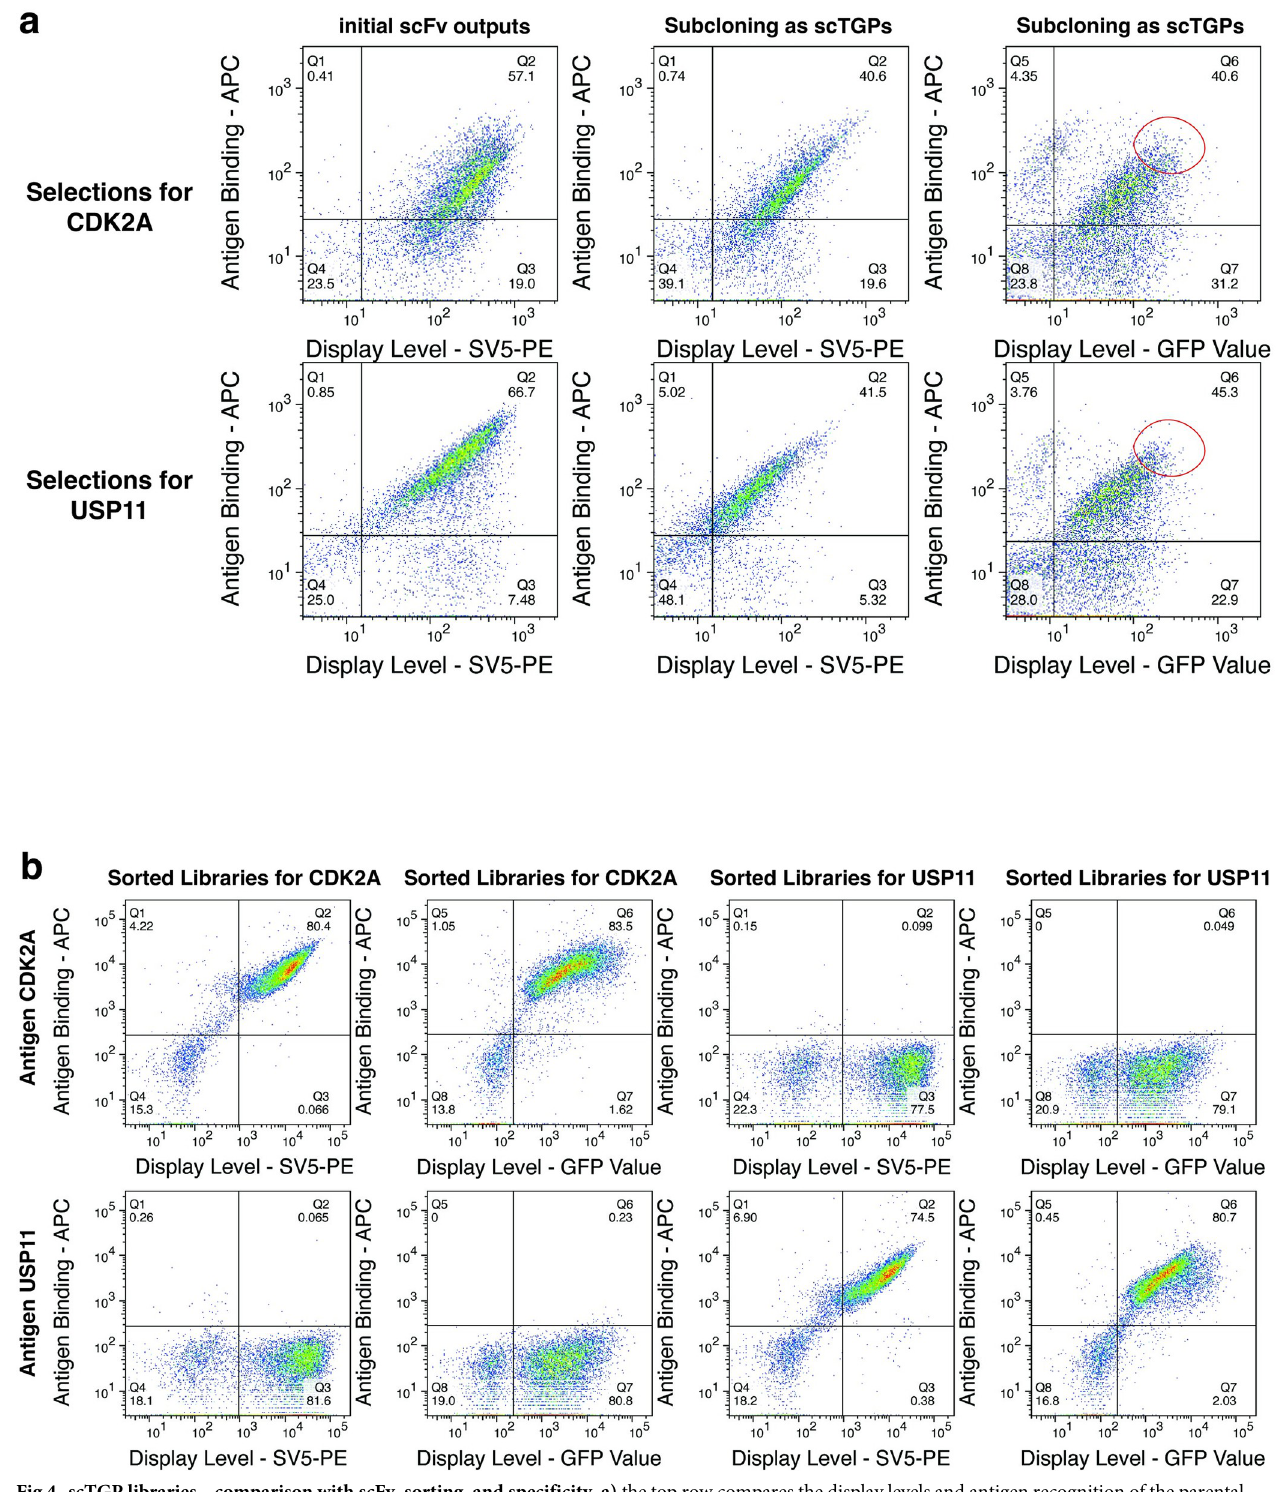
Fig 4. scTGP libraries—comparison with scFv, sorting, and specificity. a) the top row compares the display levels and antigen recognition of the parental scFv libraries and the corresponding scTGP libraries. The display levels shown on the x-axis were assessed with anti-SV5 labeled with PE (YG-PE) or the intrinsic green fluorescence of TGP. The PE signal is detected at 561nm excitation and 582/15nm emission and the TGP fluorescence is detected at 488nm excitation & 530/30nm emission. The y-axis depicts the antigen recognition signal obtained using biotinylated antigen plus streptavidin Alexa 633 at 635nm